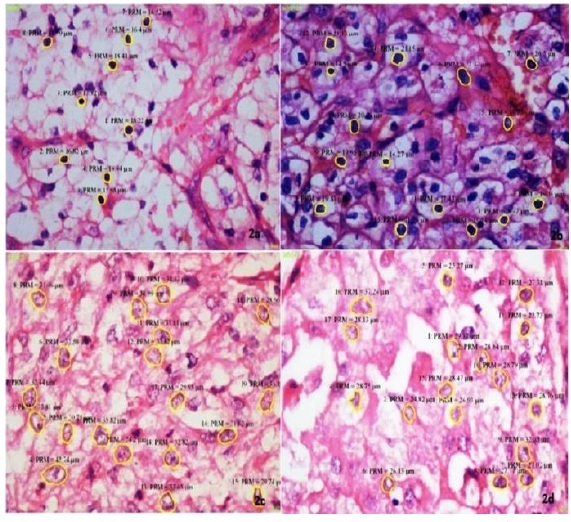
Fig 2. Nuclear morphometry in clear cell RCC (H&E, x400)